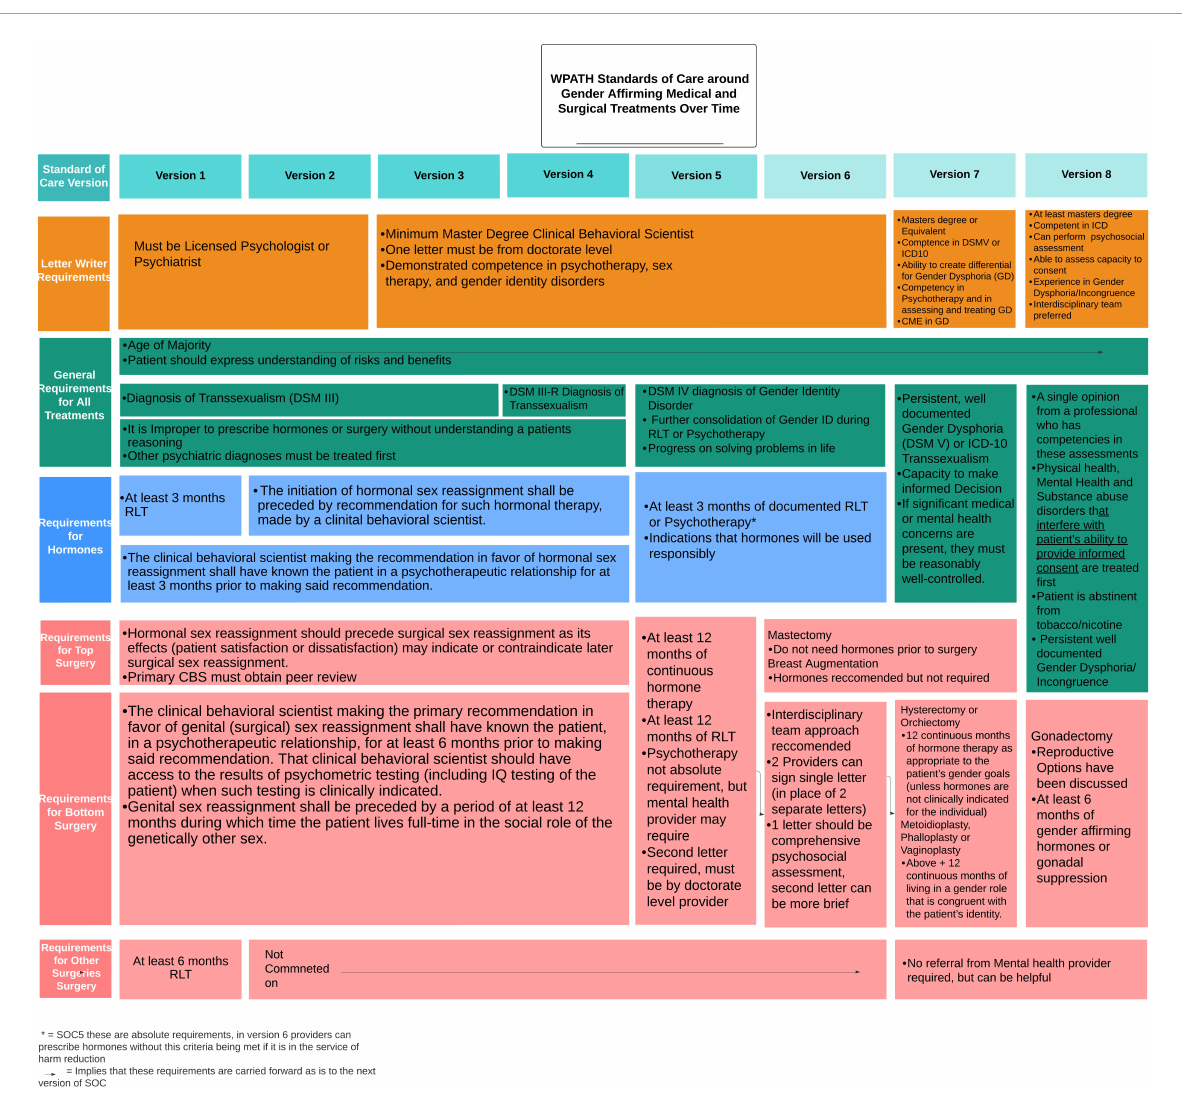
classification and consistency of gender identity over time (17,